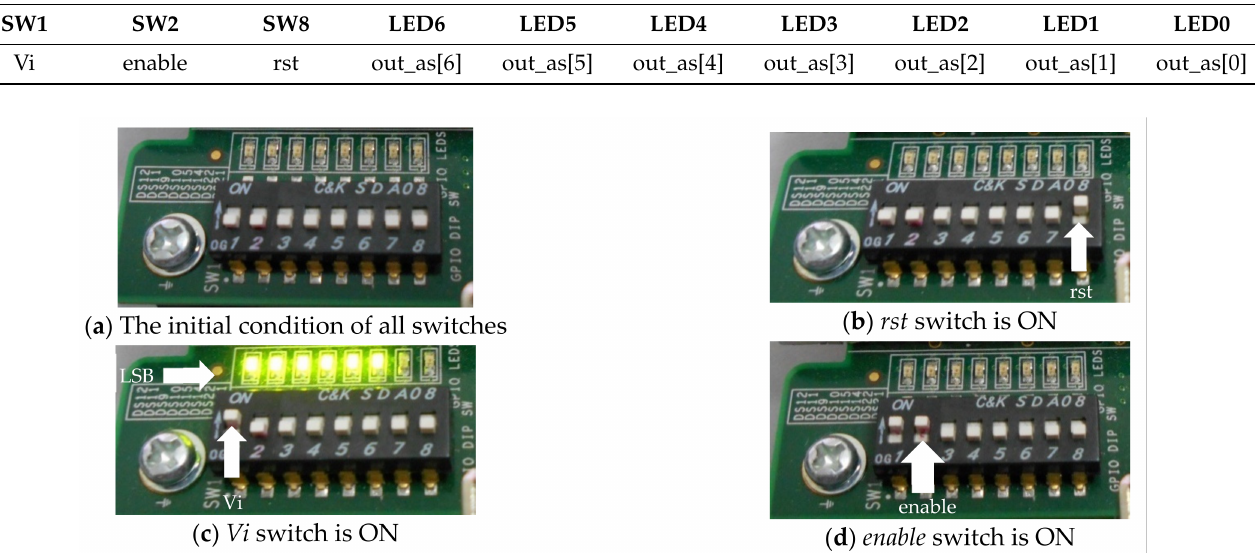
Figure 13. Output result for the experiment on automatic clock